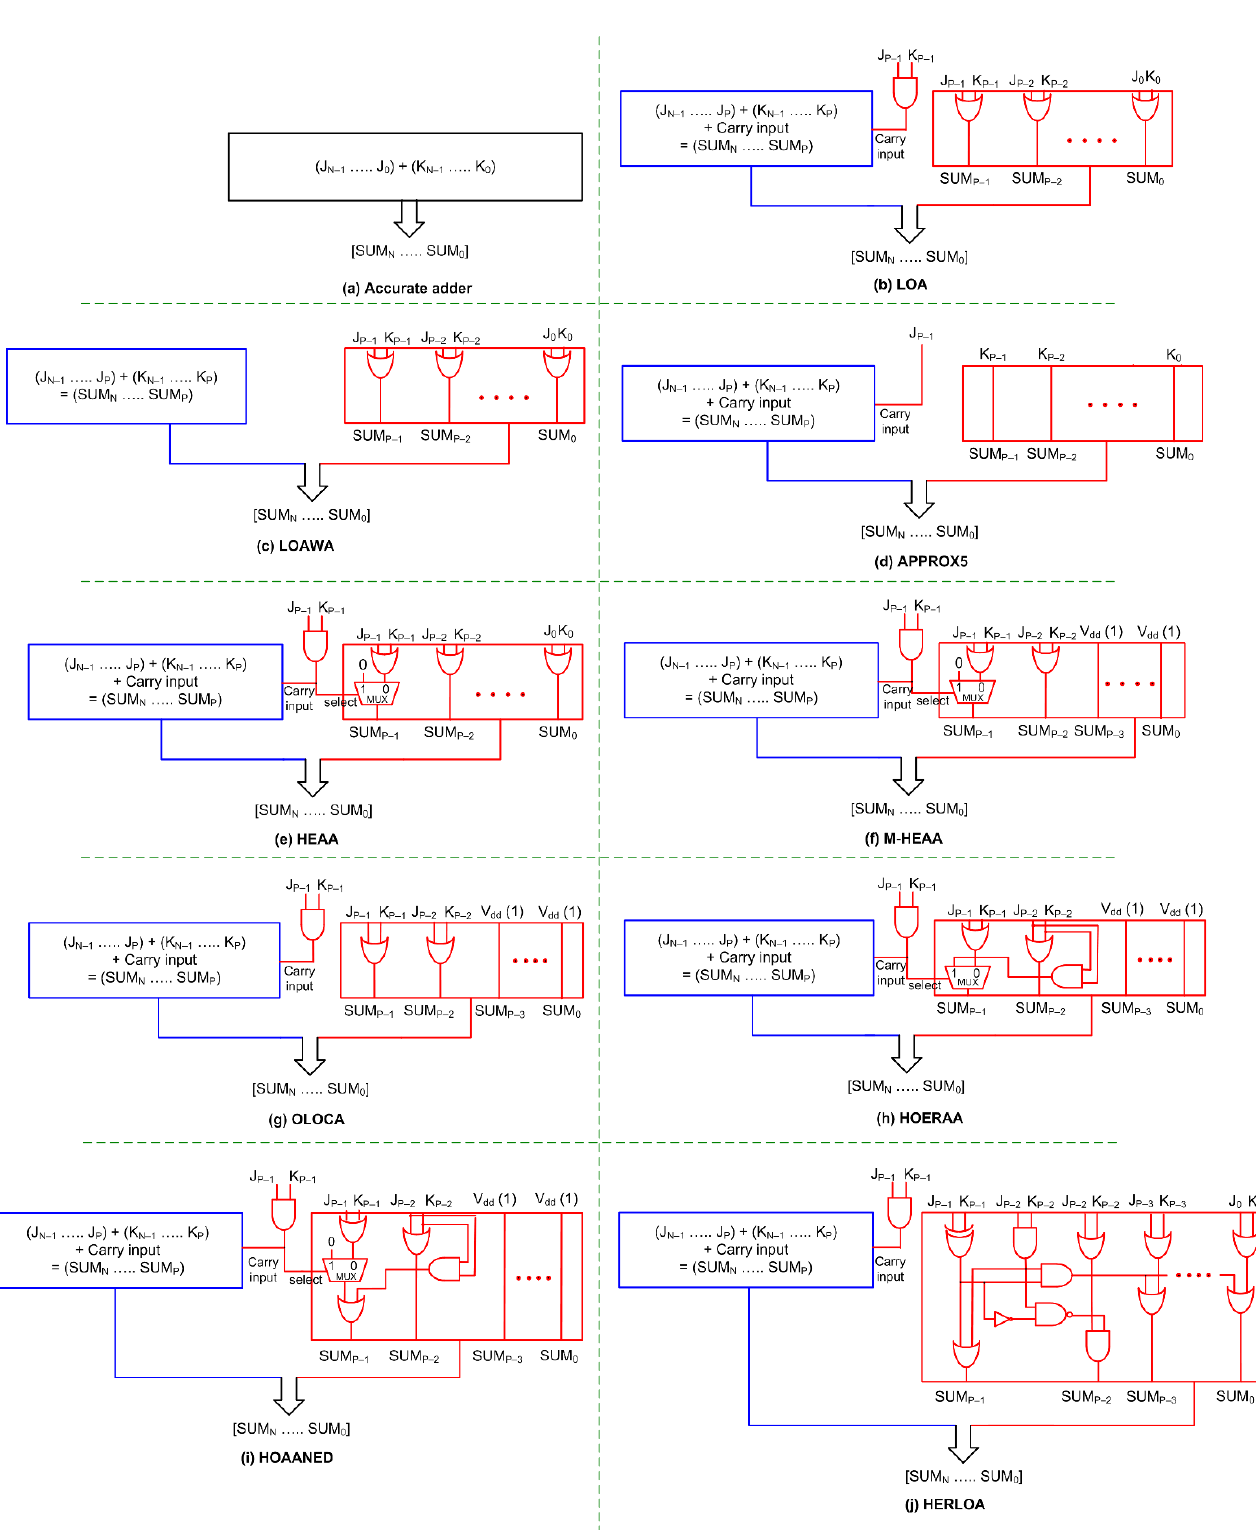
Figure 1. Architectures of accurate adder and approximate adders: ( a ) accurate adder and ( b – j ) various approximate adders.